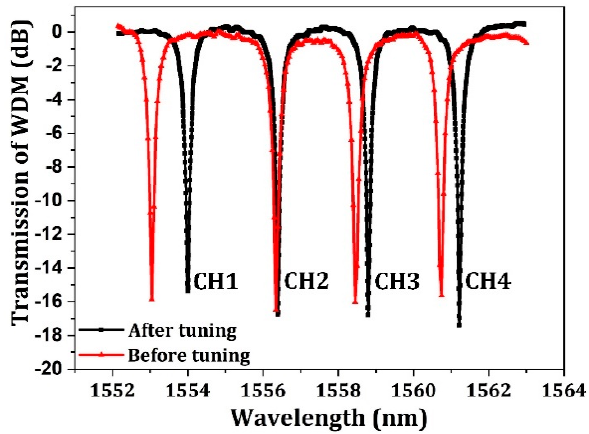
Figure 8. Normalized optical spectra of microring multiplexer before and after thermal tuning with a channel space of 2.4 nm.